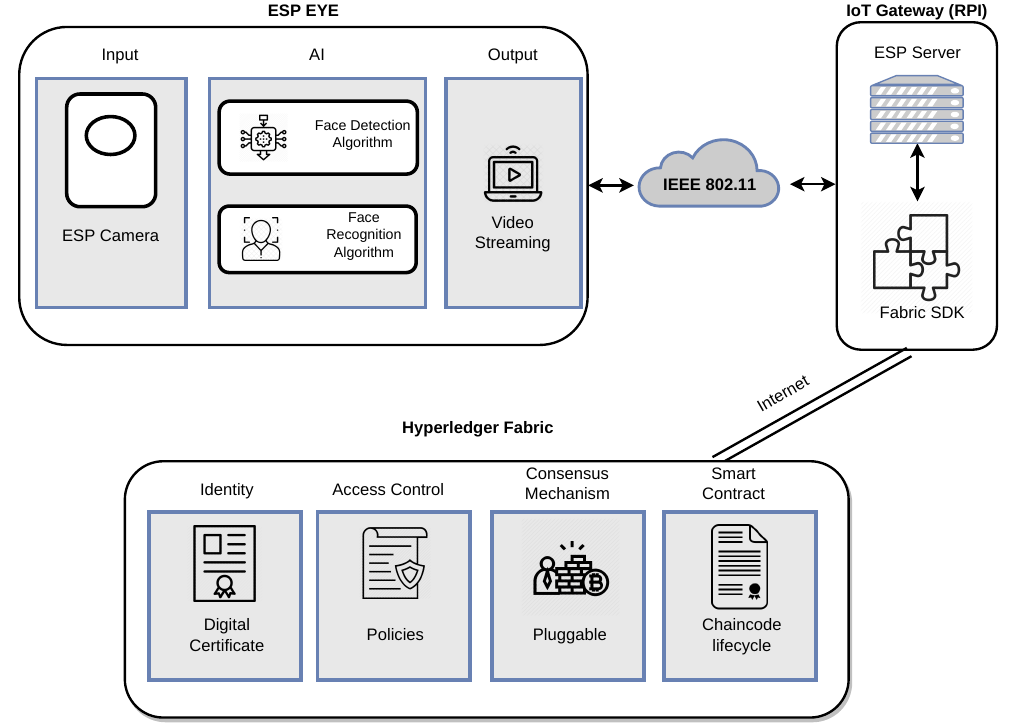
Figure 4. Software